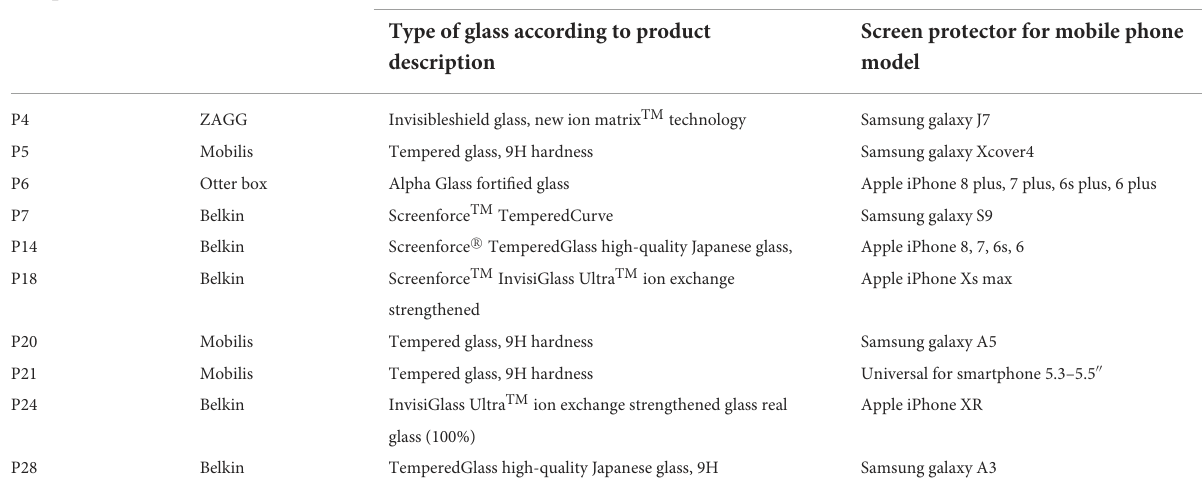
TABLE 1 Screen protectors used in this